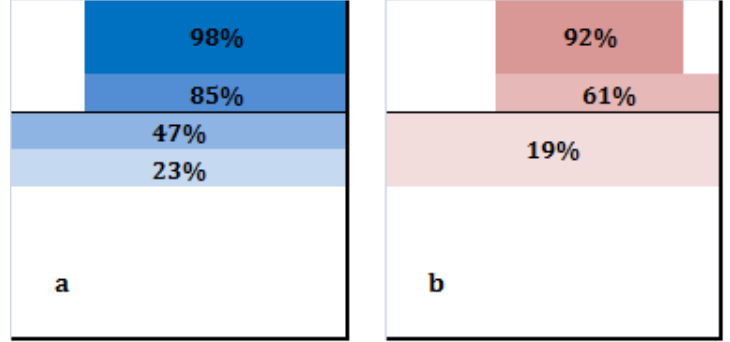
Figure 5. Probability of first tempo availability in male ( a ) and female ( b ) category according to the position of the setter in the moment of the set.